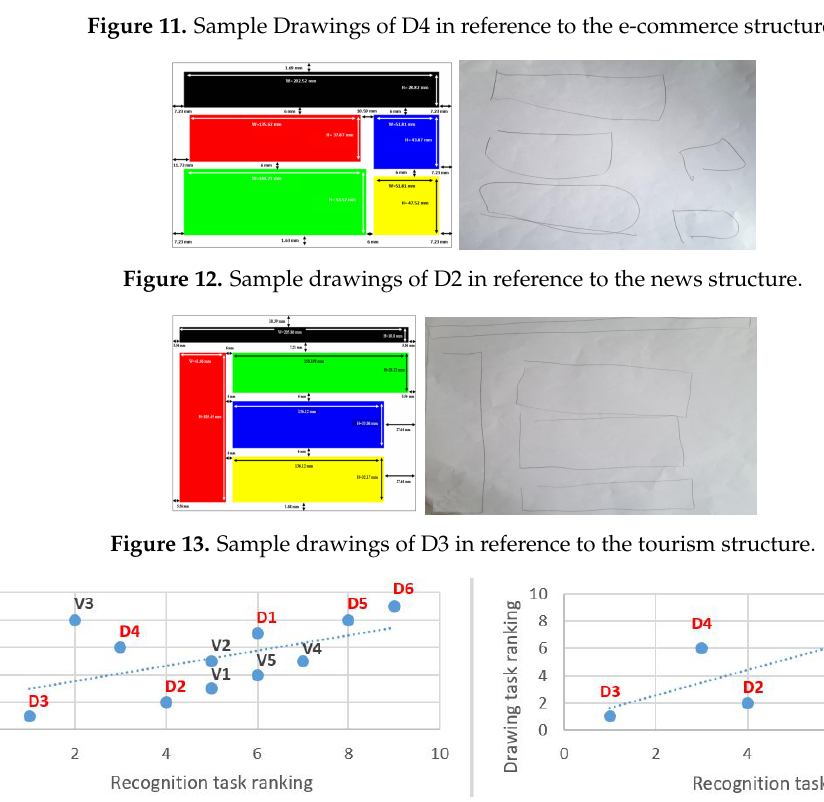
Figure 14. Recognition and drawing tasks: correlation for all subjects ( left ) and for the blind ( right